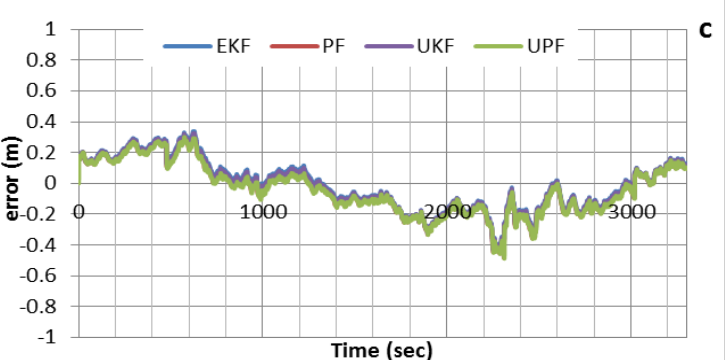
Figure 3. Positioning errors for various filters, with no GPS outages inserted. ( a ) Positioning errors in latitude; ( b ) Positioning errors in longitude; ( c ) Positioning errors in altitude.